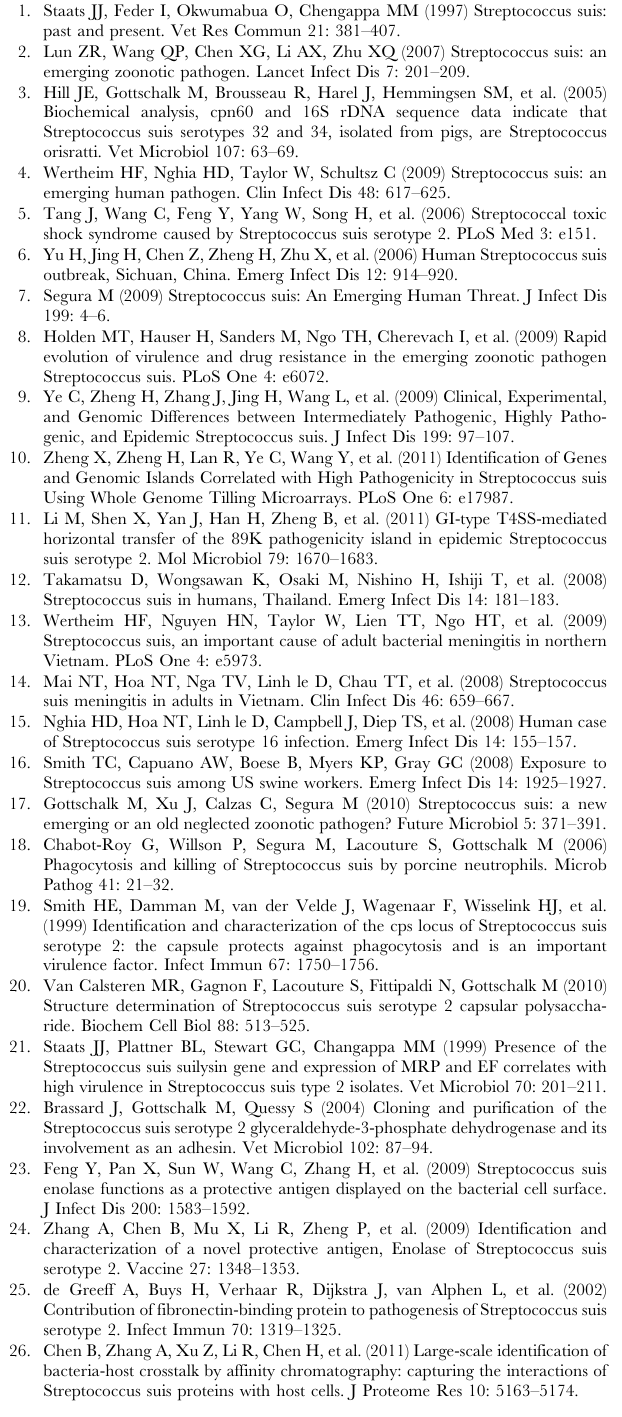
Table S5 Primer sequences used for